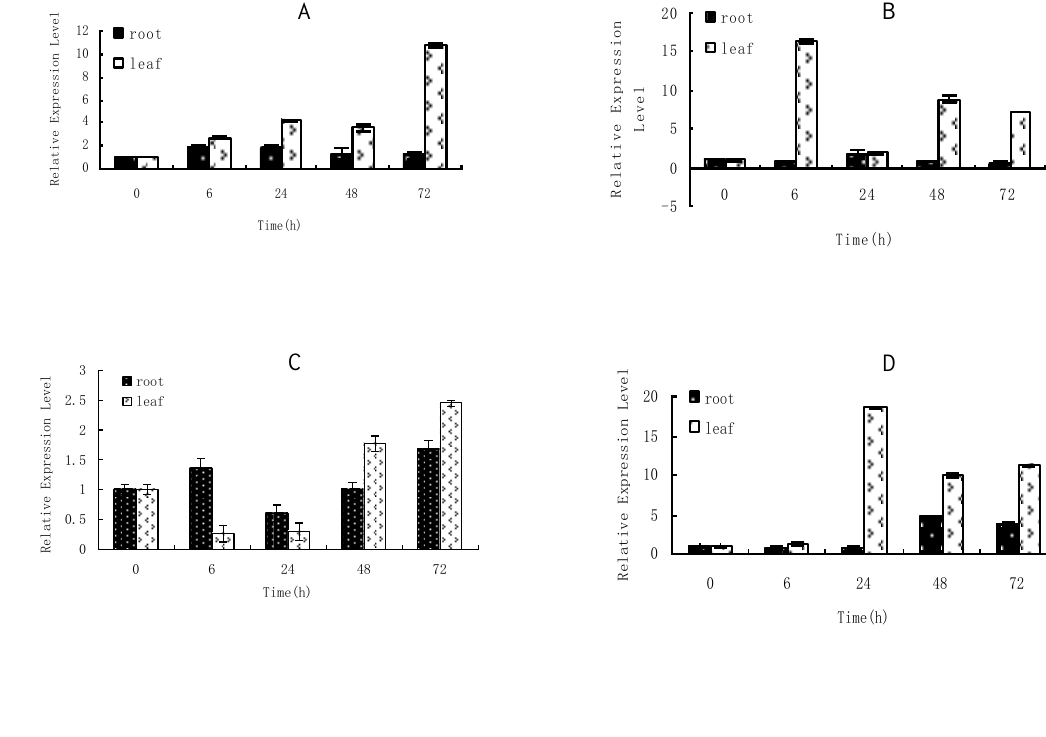
Figure 1. Time course analyses of the expression of TaLEA1 in response to different abiotic stresses by using qRT-PCR. A : 0.4 M NaCl; B : 150 µM ZnCl CuSO stress; D : 150 µM CdCl stress. qRT-PCR data was normalized using α-tubulin and 4 2 β-actin genes from T. androssowii and is shown relative to 0 h.